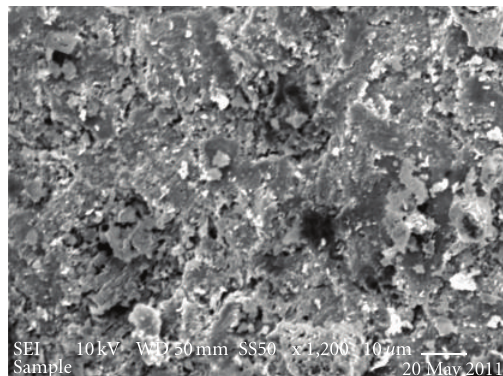
Figure 10: Electron micrograph of the sediment collected at sam- pling point 5 (March of 2007—Magnification of 1.200 ×